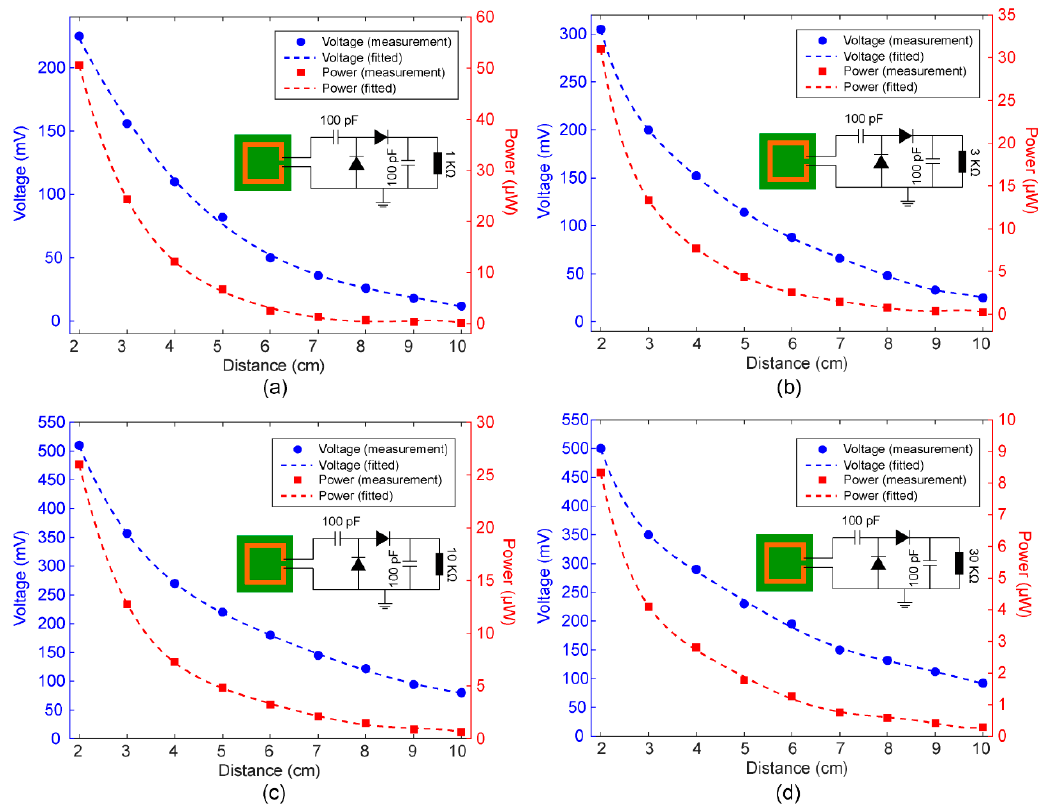
Figure 6. Measured output DC voltages and calculated output powers with different load re- sistances at 2.425 GHz. ( a ) 1 K Ω . ( b ) 3 K Ω . ( c ) 10 K Ω . ( d ) 30 K Ω . The inset depicted the detailed at 2.425 GHz. ( a ) 1 K Ω . ( b ) 3 K Ω . ( c ) 10 K Ω . ( d ) 30 K Ω . The inset depicted the detailed schematic schematic diagram of PCB circuits with various resistors. diagram of PCB circuits with various